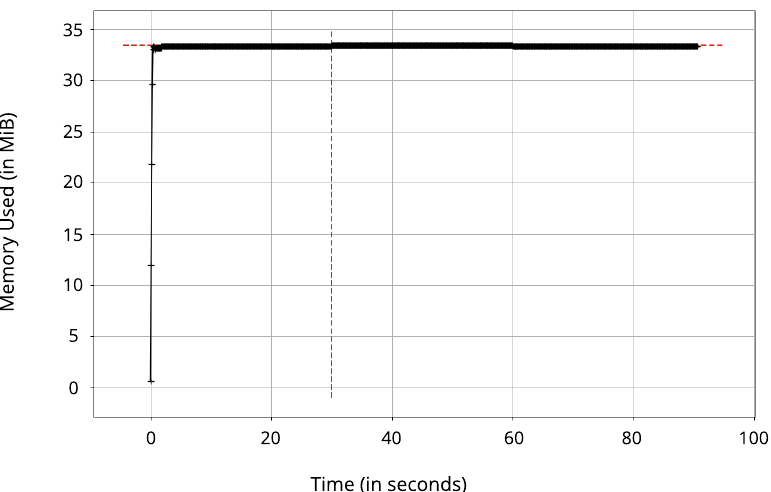
Figure 8. Memory consumed as a function of time when running the platform, where the average consumption is 34.33